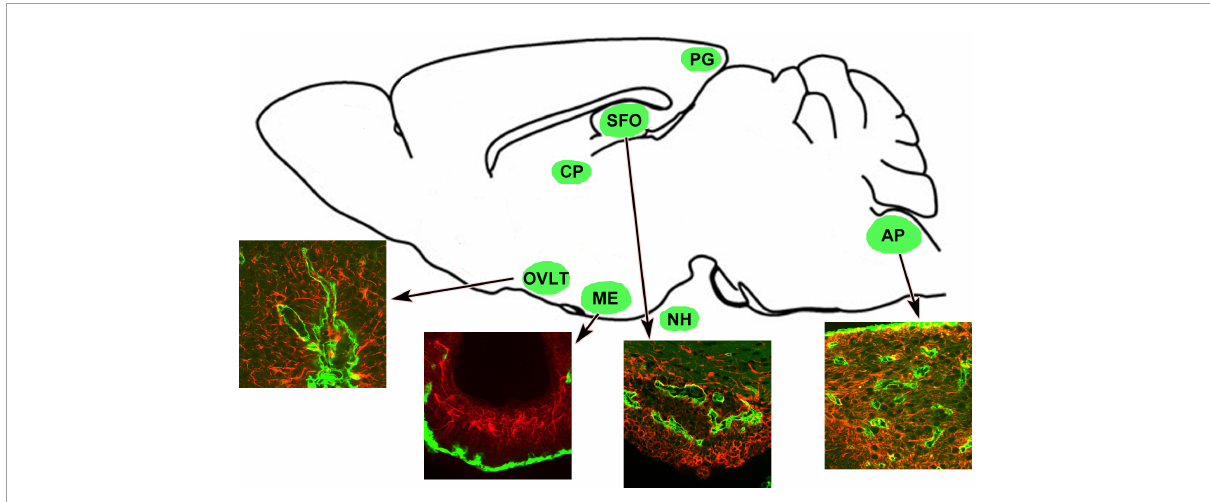
FIGURE1 Schematic representation revealing CVOs locations in the adult rodent brain. Insets indicate that the CVOs are characterized by dense and thick laminin + (green) capillaries and dense GFAP + (red) astrocytic and tanycytic networks. Scale bar = 50 µ m. AP, area postrema; CP, choroid plexus; GFAP, glial fibrillar acidic protein; ME, median eminence; NH, neurohypophysis; OVLT, organum vasculosum of the lamina terminalis; PG, pineal gland; SFO, subfornical organ. The illustration is rearranged with permission from Elsevier B.V. (Takagi et al.,